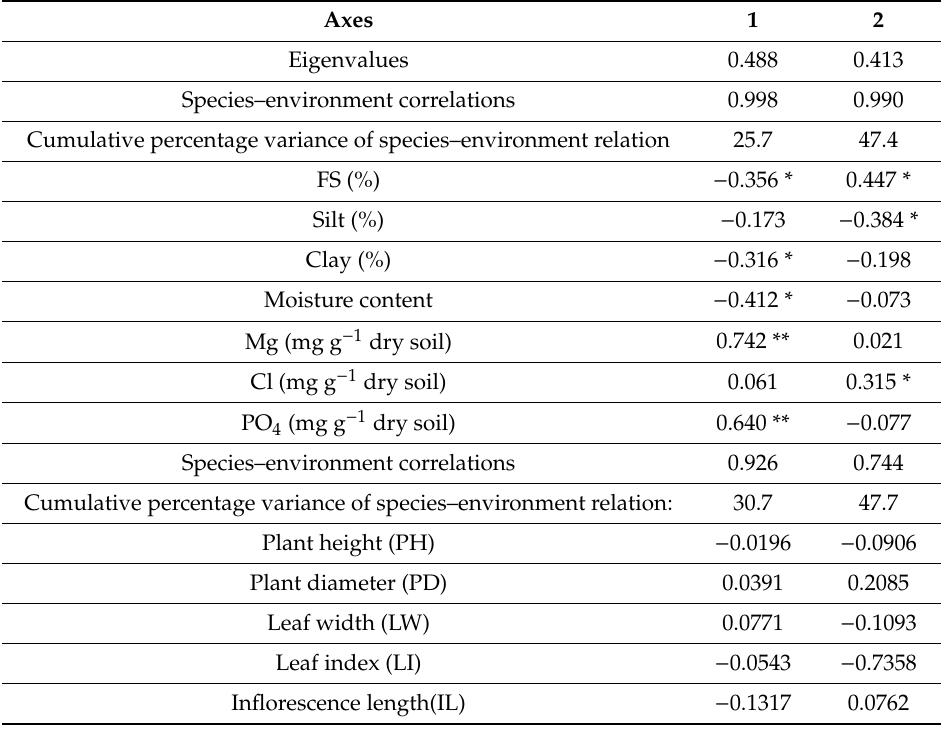
Figure 6. Canonical correspondence analysis (CCA) biplot of axes 1 and 2 showing the distribution of the 10 sites of the study area of A. javanica populations with their vegetation groups, soil variables, and morphological characters. LI = leaf Index, LW = leaf width, PH = plant height, PD = plant diameter, IL = inflorescence length. All other soil parameters and plant traits were excluded due to insignificance. Table 4. Inter-set correlation of CCA analysis for the soil variables, together with eigenvalues and species–environment correlations for the 10 examined populations of Aerva javanica